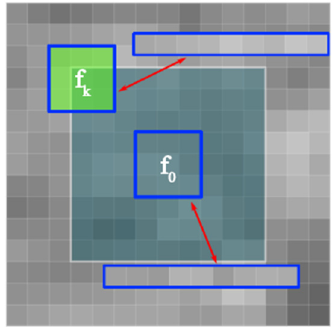
Figure 8. Nonlocal similar block matching diagram.